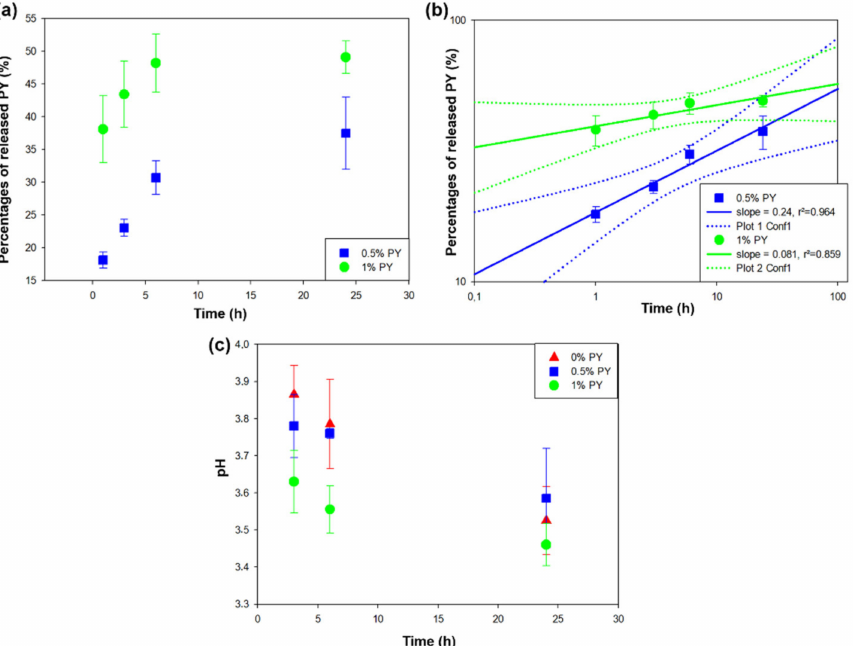
Figure 4. ( a ) Percentages of the PY released from the adhesives doped with 0.5% and 1% PY over time for two independent experiments). ( b ) The data from part ( a ) are plotted in a double logarithmic representation and fitted with straight lines whose slope is given in the inset. The dotted lines correspond to the limits of the 95% confidence intervals. ( c ) pH changes with time of water put in contact with the adhesive (control), adhesive + 0.5% PY, and adhesive + 1% PY. The experimental conditions are indicated in the